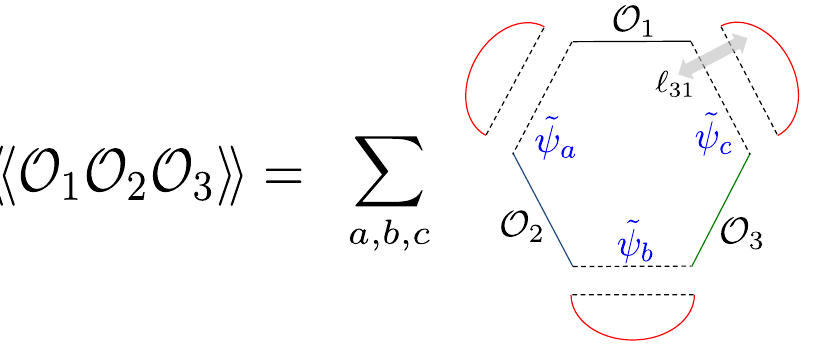
Figure 16 . Hexagonalization of the four-point functions. We draw all tree-level graphs, decorate them by inserting nontrivial states on the dashed edges and compute the contribution from each hexagon.